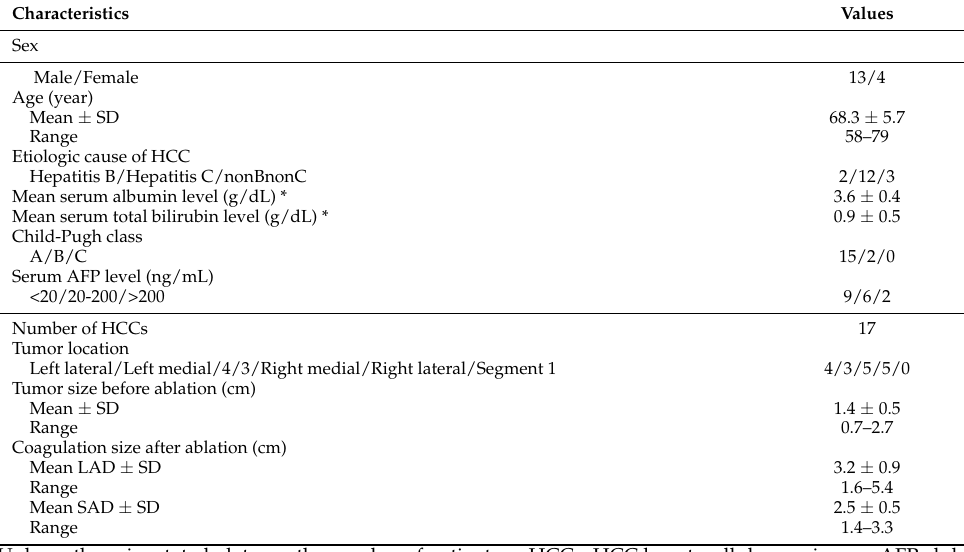
Table 1. Baseline Clinical Characteristics of